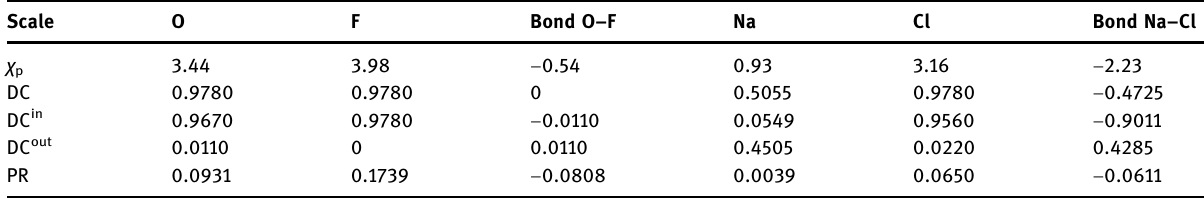
Table 5: The di ff erence between element electronegativity and node importance in bond O – F and bond Na – Cl Scale